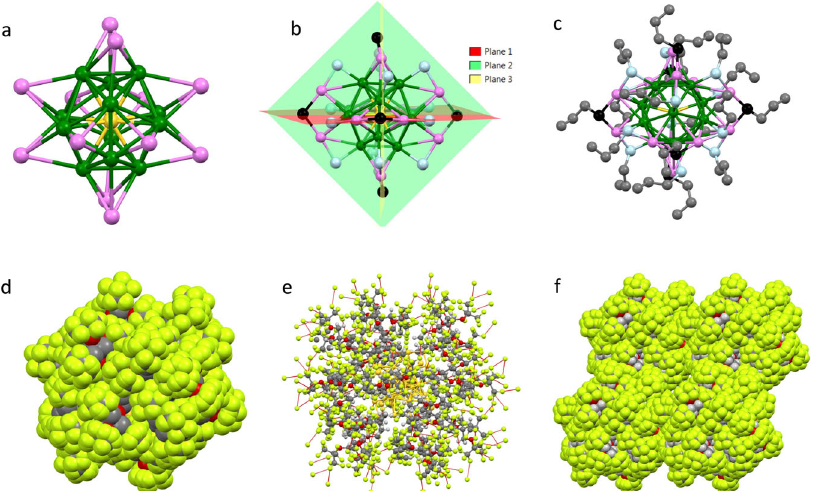
Fig. 4 Crystallography of [Au 25 (SF 27 ) 18 ] 0 (Mercury CSD 4.2.0). a Au 25 core. Color code: Au cent in yellow, Au inn in green, Au out in pink; b Au 25 S 18 unit, highlighting the six S – Au out – S – Au out – S staple motifs and the three planes they lay on. Sulfur atoms are colored in light blue (terminal) and black (bridged), respectively; c Au 25 S 18 unit with C 3 alkyl portion of each thiol. The carbon atoms are colored in gray; d representation of one [Au 25 (SF 27 ) 18 ] 0 NC showing the fl uorine masking of the gold core; e representation of one [Au 25 (SF 27 ) 18 ] 0 NC where the inter-cluster F···F contacts are shown as red dotted lines; f overall crystal packing of four [Au 25 (SF 27 ) 18 ] 0 NCs, view along the crystallographic b axis. a – c , e in ball-and-stick model, d , f in space- fi ll model.